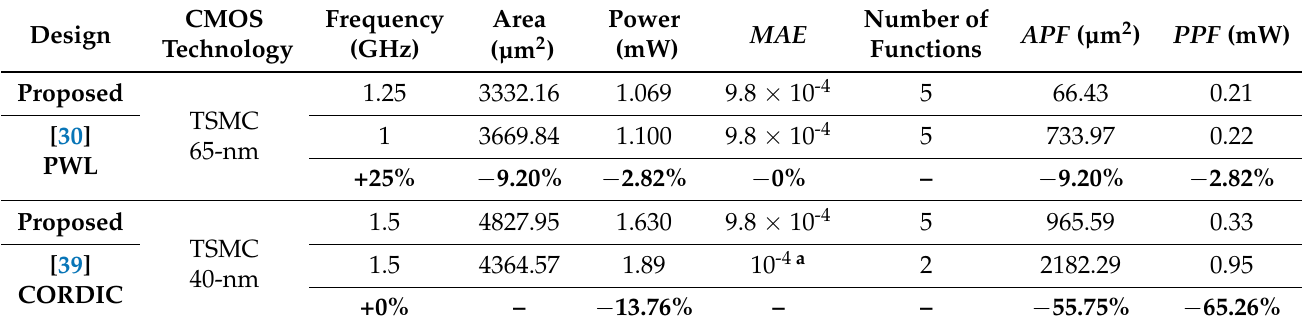
Table 4. ASIC implementation results of designs for multifunction